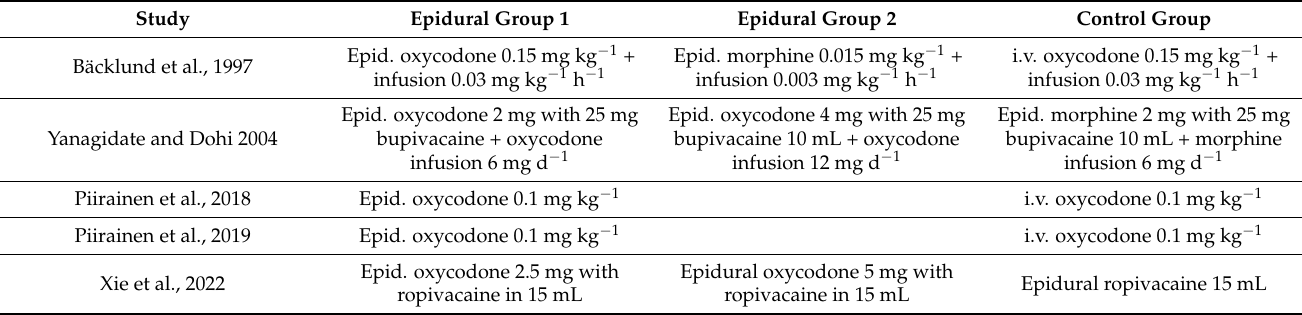
Table 2. Medication protocols in randomised controlled trials (RCT) on analgesic efficacy of epidural (epid.) oxycodone. i.v.,